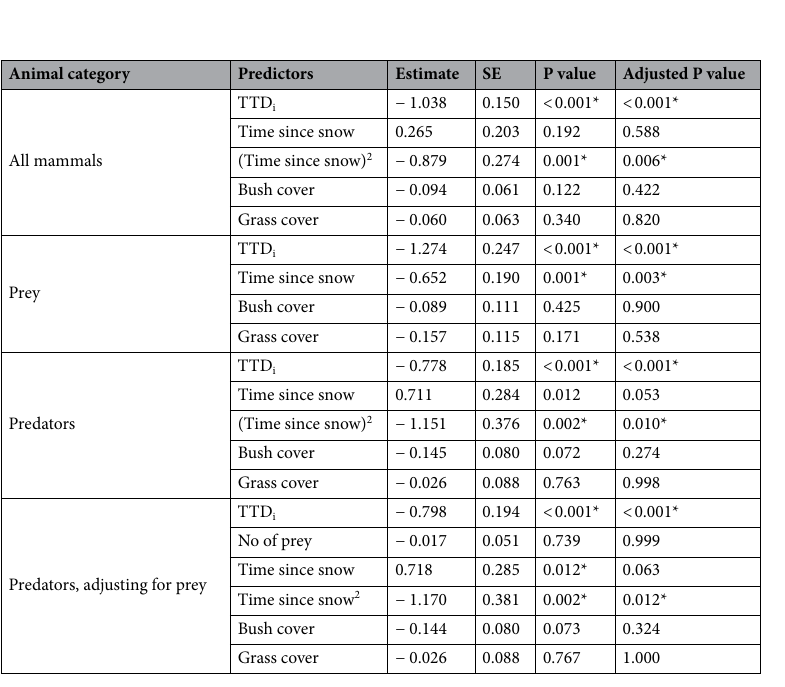
Table 1. Regression table for the four tested GLMMs, as a function of the animal categorization and the confounding variables considered. *Significant at α <